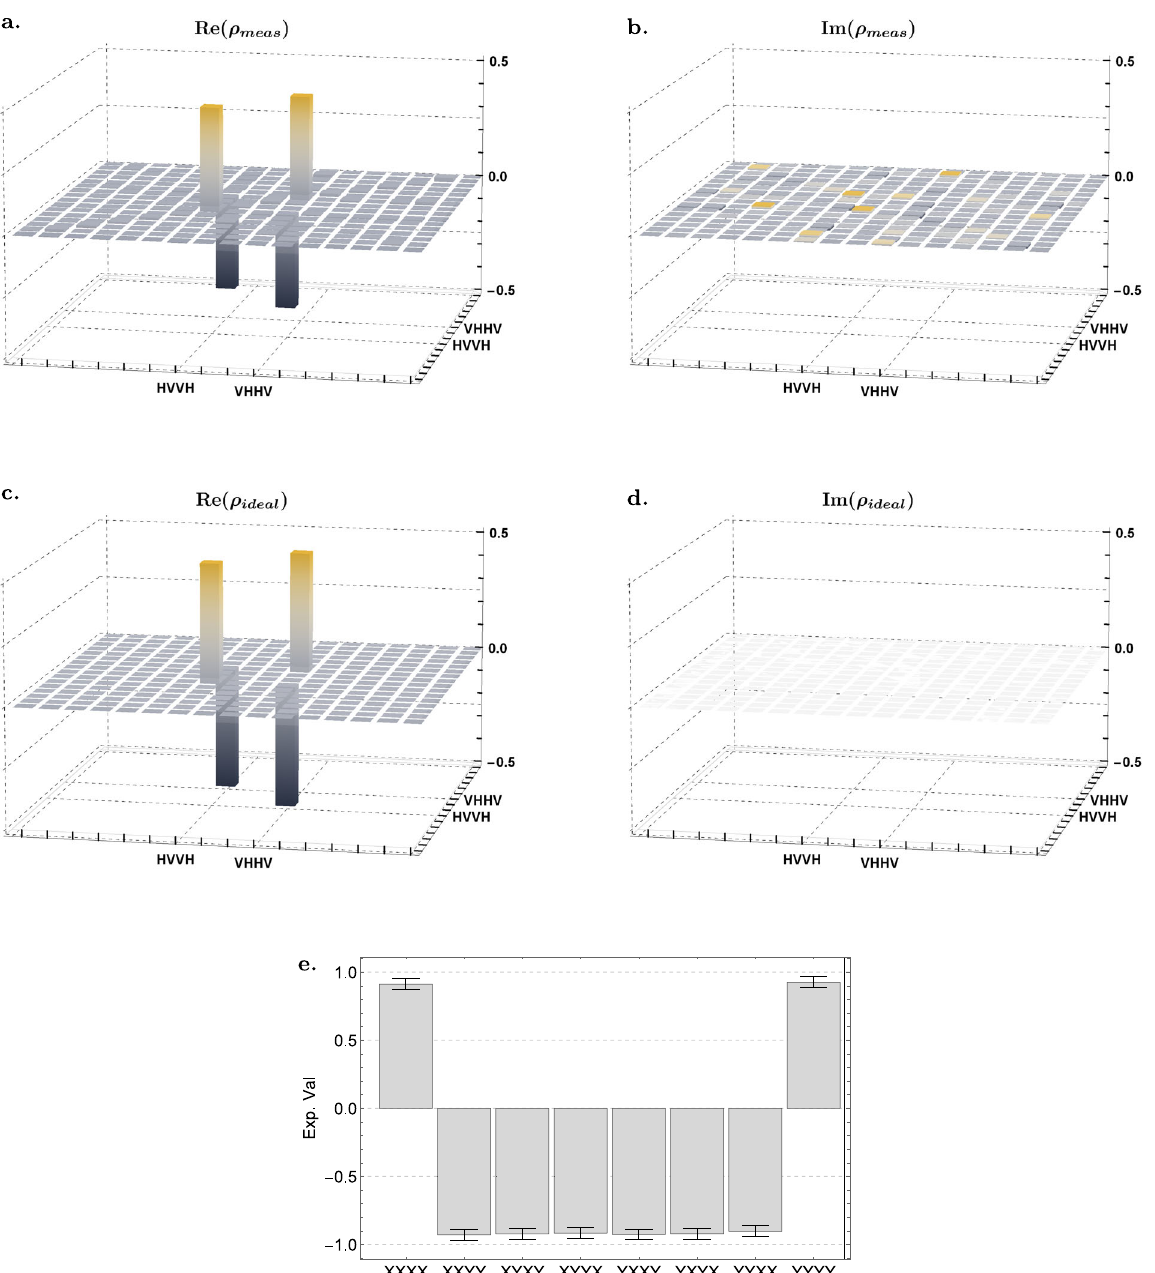
Fig. 5 Tomography and expectation value. Panels a – d . show the measured real and imaginary part of the quantum state ρ exp calculated by a maximum likelihood estimation from the measured 4-fold coincidence counts as well as their ideal cases. e . Calculated expected values obtained by the probability measurements of 4 2 = 16 combinations to measure H or V polarized photons. The data was measured at 100 mW pump